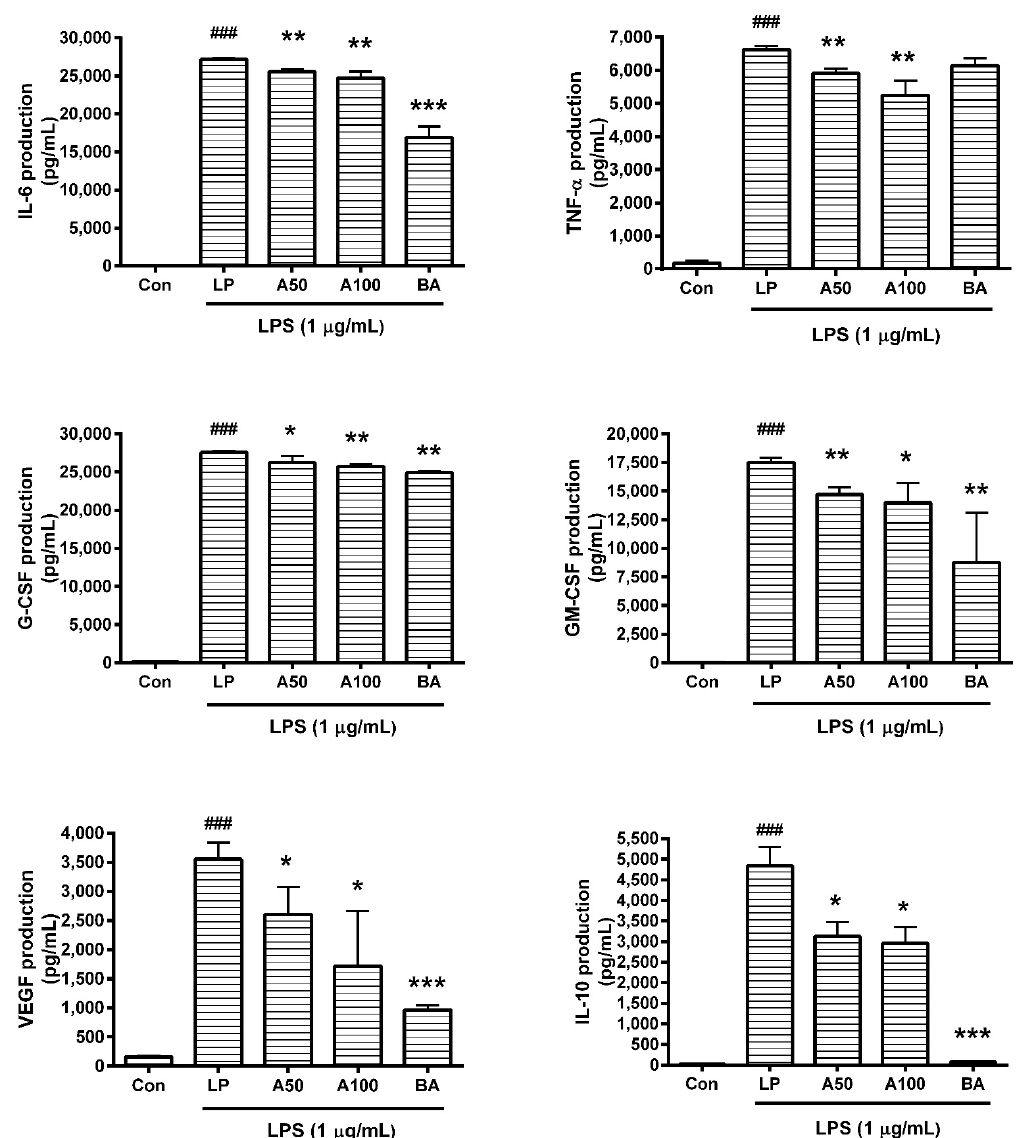
Figure 2. Effects of Angelica sinensis root water extract (ASW) on interleukin (IL)-6, tumor necrosis factor (TNF)- α , granulocyte colony-stimulating factor (G-CSF), granulocyte macrophage colony-stimulating factor (GM-CSF), vascular endothelial growth factor (VEGF), and IL-10 production in lipopolysaccharide (LPS)-induced RAW 264.7. Cells were treated for 24 h. Con means the group treated with media only. LP means the group treated with 1 µ g/mL of LPS alone. A50 and A100 mean 50 and 100 µ g/mL of ASW, respectively. BA means baicalein (100 µ M). Values are the mean ± standard deviation of at least three independent experiments. Statistical significance was calculated by one-way ANOVA and a Tukey multiple comparison test. ### p < 0.001 vs. Con; * p < 0.05 vs. LP; ** p < 0.01 vs. LP; *** p < 0.001 vs.